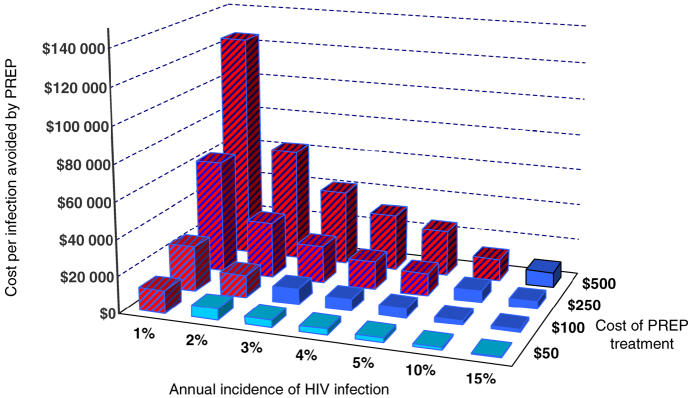
Cost-Effectiveness of PREP with a 40% Efficacy RateThis graph shows the cost per infection avoided by PREP (US$) by annual HIV incidence (%) and by cost of PREP treatment (US$), assuming PREP cuts incidence of HIV infection by 40%. The striped bars indicate that the cost per infection avoided by PREP was over $10,000 and was therefore not considered to be cost-effective.